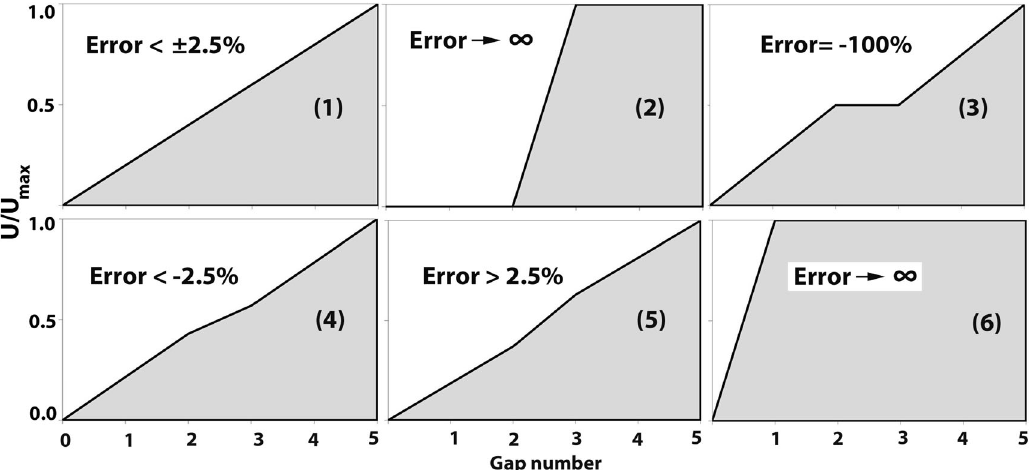
FIG. 7. Troubleshooting chart for express identification of faults in the high-voltage grading system of an electrostatic accelerator based on a noninvasive test with an electrometer. The vertical axis for all graphs is the normalized voltage distribution across 5 gaps corresponding to different fault conditions such as (1) fault-free system; (2) open circuit in gap 3; (3) short circuit in gap 3; (4) lower resistance in gap 3; (5) higher resistance in gap 3, and (6) open circuit in gap 1. A 5 gap structure is selected for simplicity and illustration purposes. The same analysis is applied to any structure with arbitrary number of gaps under test.